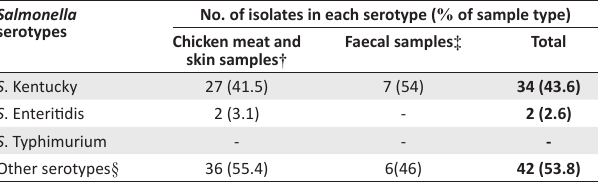
TABLE 2: Distribution of serotypes for the 78 Salmonella isolates recovered from poultry and faecal samples collected between December 2011 and May 2012. Salmonella